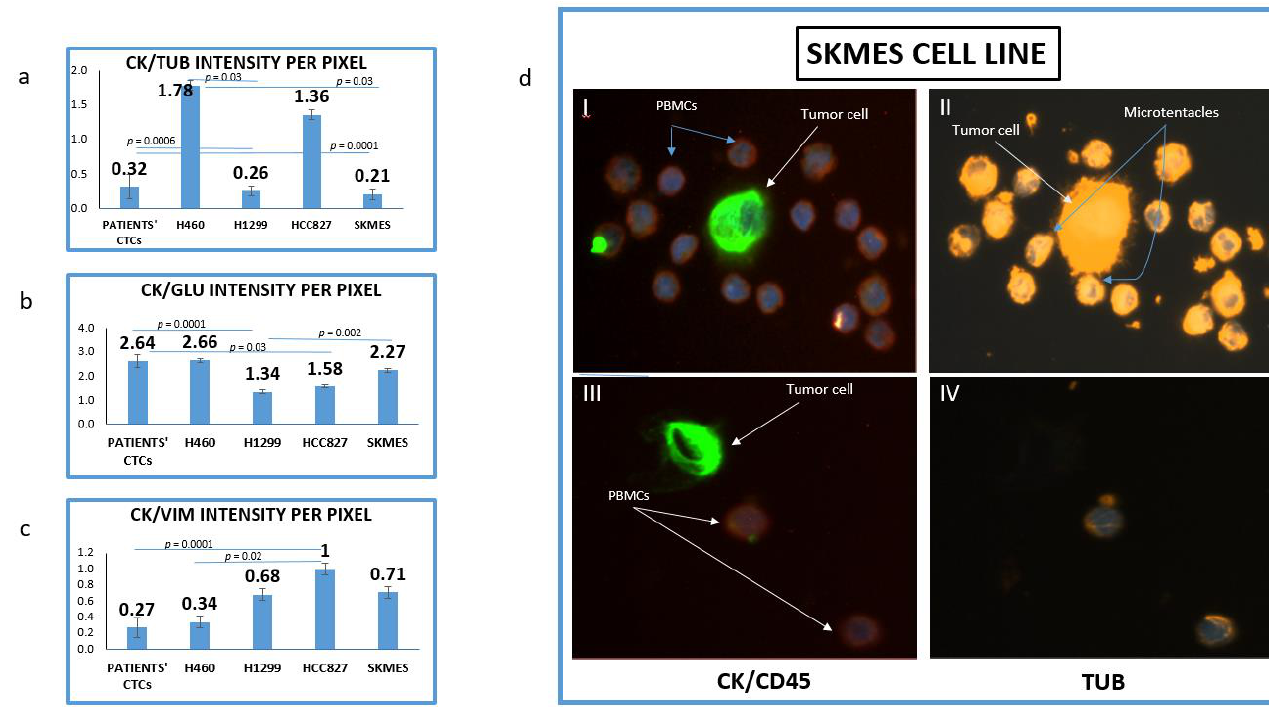
Figure 1. Expression of Cytokeratin (CK), alpha-Tubulin (TUB), Detyrosinated Tubulin (GLU) and vimentin (VIM) in lung cancer cell lines. ( a ) Quantification of (CK/TUB ratio) intensity per pixel in Lung cancer cell lines using Image J software; ( b ) Quantification of (CK/GLU ratio) intensity per pixel in Lung cancer cell lines, using Image J software; ( c ) Quantification of (CK/VIM ratio) intensity per pixel in Lung cancer cell lines, using Image J software; ( d ) Representative image of SKMES lung cancer cells spiked in normal blood donors’ PBMCs, obtained from Fluorescenc e microscope o f patients’ CTCs ( ×40). (I, II) SKMES cells positive for Cytokeratin (green) negative for CD45 (red), positive for Tubulin (orange) and DAPI (blue) and (III, IV) SKMEs cell positive for CK (green), negative for CD45 (red) and negative for TUB.